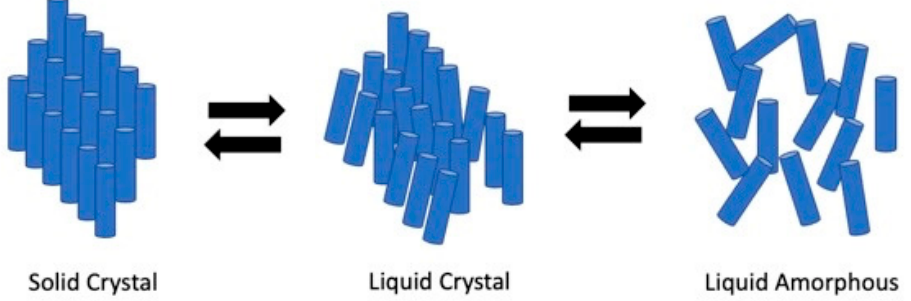
Figure 1. Illustration of rod-like particles of solid crystal, liquid crystals, and liquid phase.